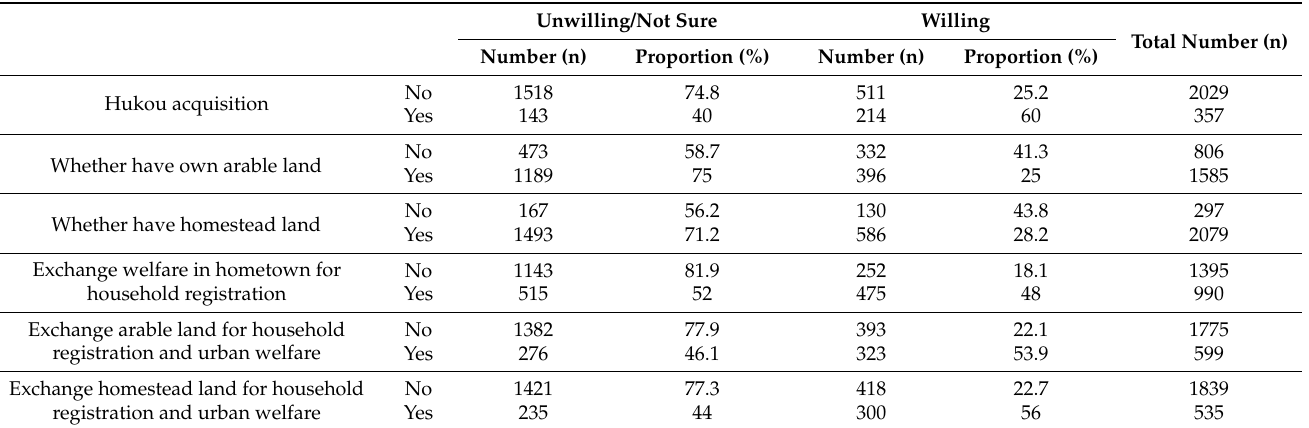
Table 6. Comparison of settlement intention among migrants with different characteristics related to household registration and land